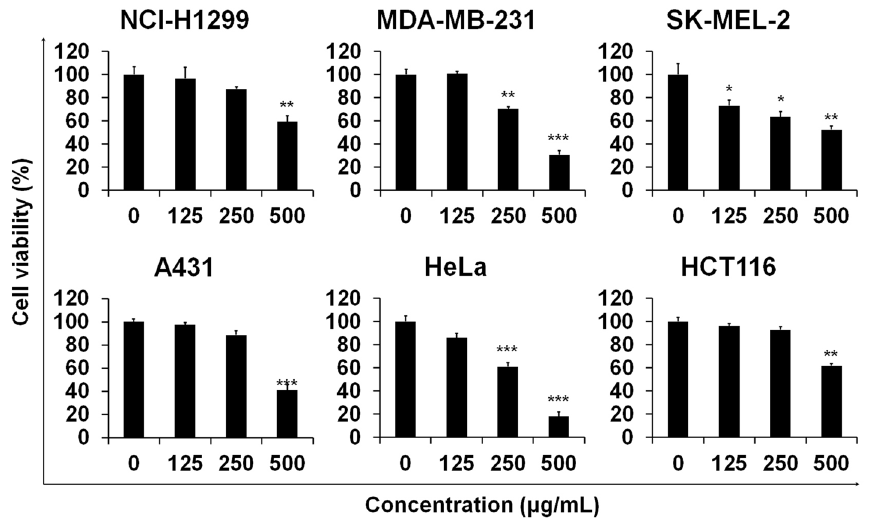
Figure 5. AOFE inhibits cell viability in other cancer cells. NCI-H1299, MDA-MB-231, SK-MEL-2, A431, HeLa, and HCT116 cells were treated with various concentration of AOFE for 24 h. AOFE-induced cytotoxicity was assessed using the MTT assay. The data are presented as the mean ± SD. Statistical analyses were performed using paired t-test. * p < 0.05, ** p < 0.01, *** p <